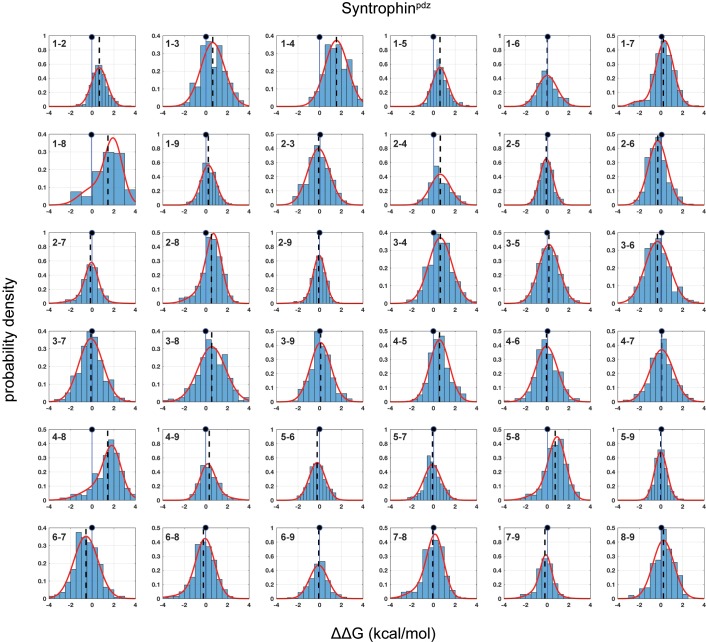
Distributions of double mutant cycles for each α2 helix position pair (numbering as in Figure 1C) for Syntrophinpdz.As in Figures 2–3, distributions are fit to single or double Gaussians, using the Bayes Information Criterion to choose the model. The position of zero coupling is indicated by the solid line and circle above, and the population weighted mean is represented in dashed lines.